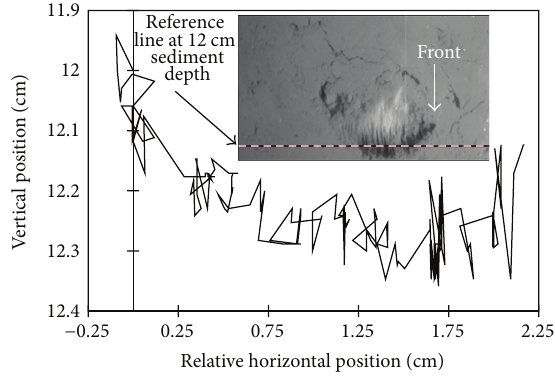
Figure 8: Movements of Brisaster fragilis during 8.75 hours of video observations against the side glass of an aquarium. Insert shows an example of captured video